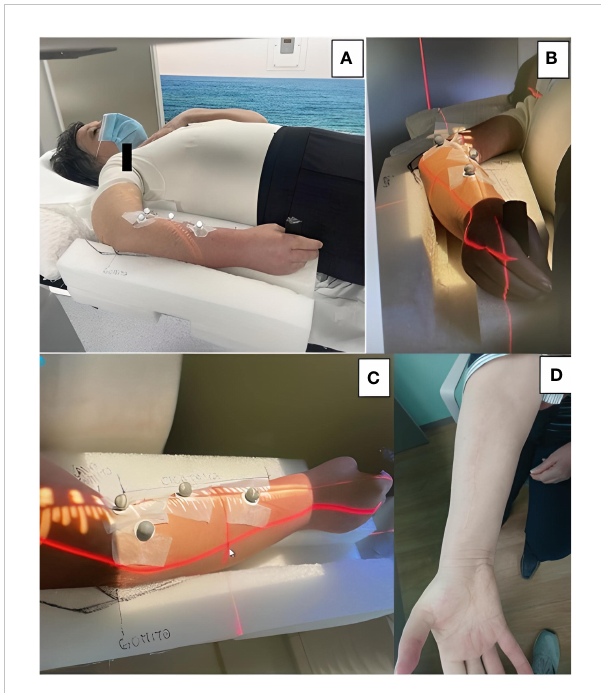
FIGURE 4 (A-C) A customized immobilization system was created by carving out foamed polyethylene. The patient gripped a cylindrical handle placed at the distal end for increased stability. (B, C) Four re fl ective body markers placed on the volar surface of the forearm were monitored by two ceiling-mounted infrared cameras for any intra- fraction target motion. (D) Satisfactory cosmetic result at the 1-year